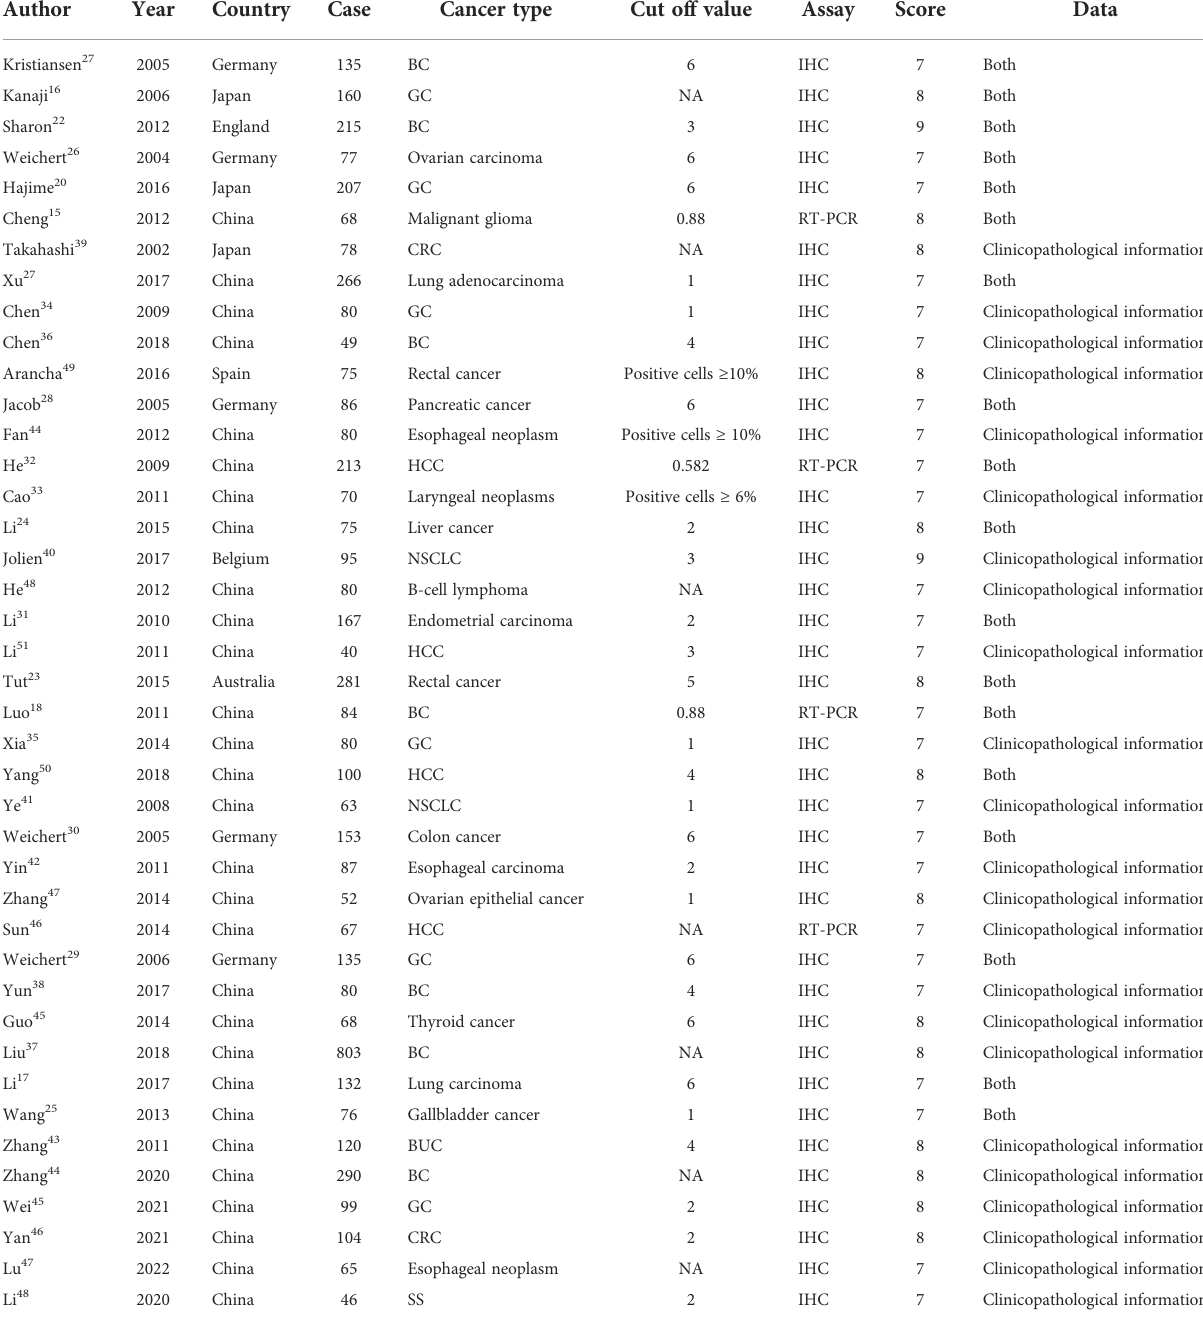
TABLE 1 Characteristics of the studies included in the